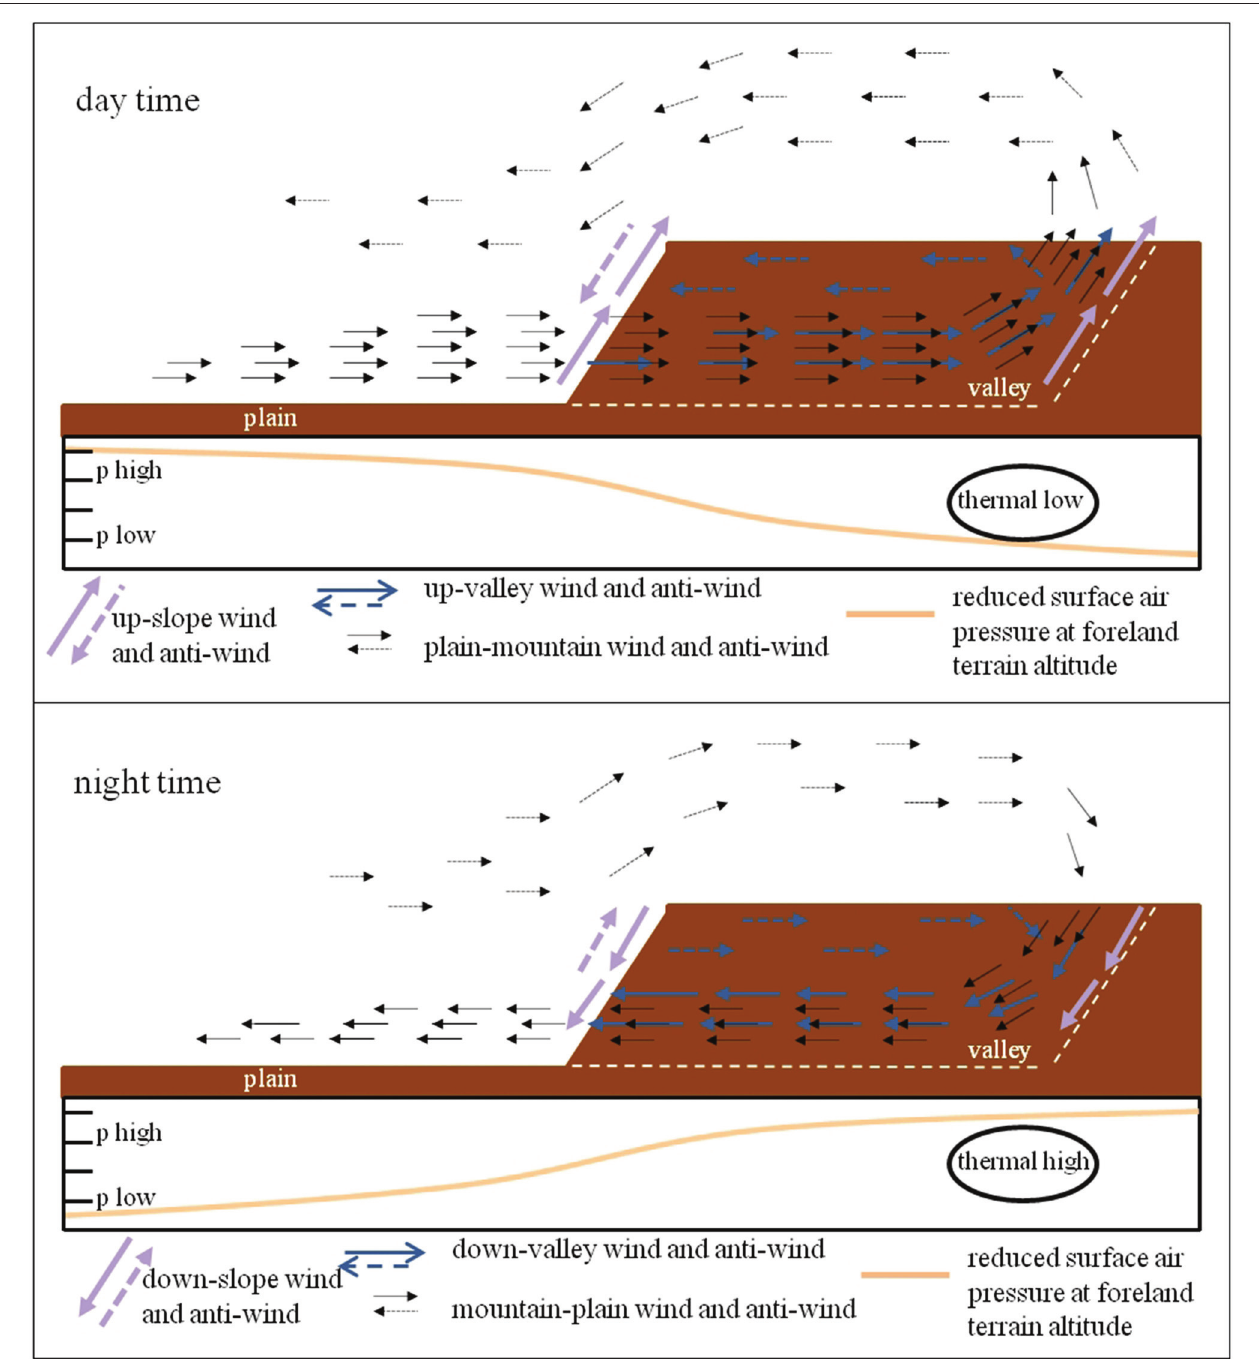
FIGURE 1 | Schematic figure of the different wind systems combining to Alpine pumping with an idealized line of surface air pressure reduced to the altitude of the foreland.